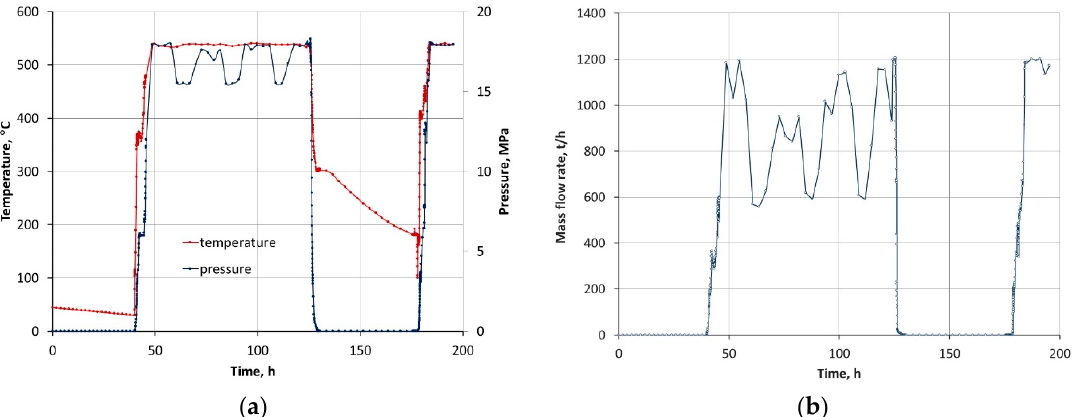
Figure 2. Graphs of pressure, temperature ( a ) and mass flow rate ( b ) of steam as a function of time recorded in the pipeline with the Y-shaped junction; a selected time period of the load history with a shortened period of steady operation.